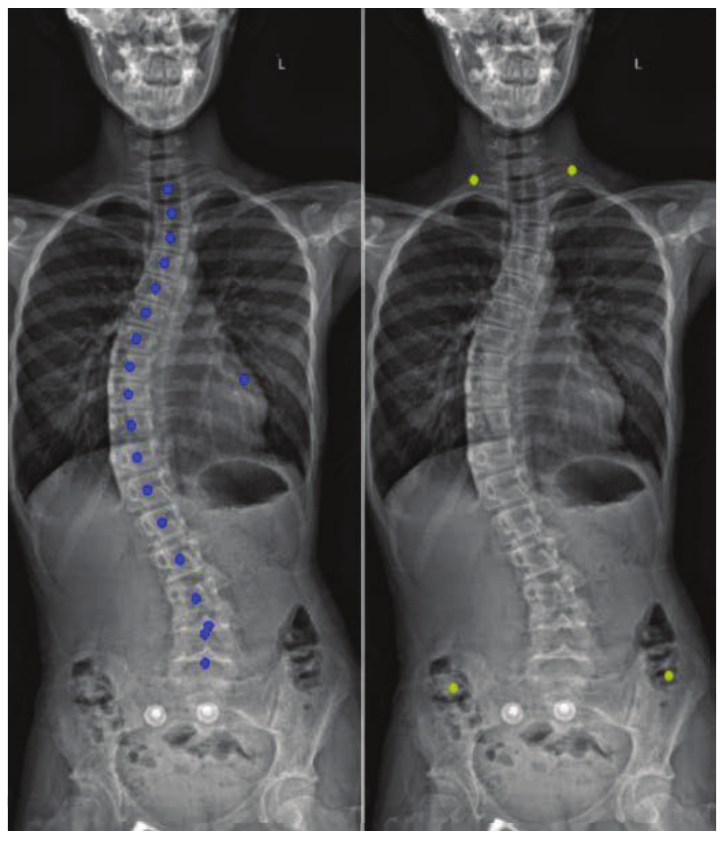
Figure 5. Prediction results of vertebral center points and four anchor